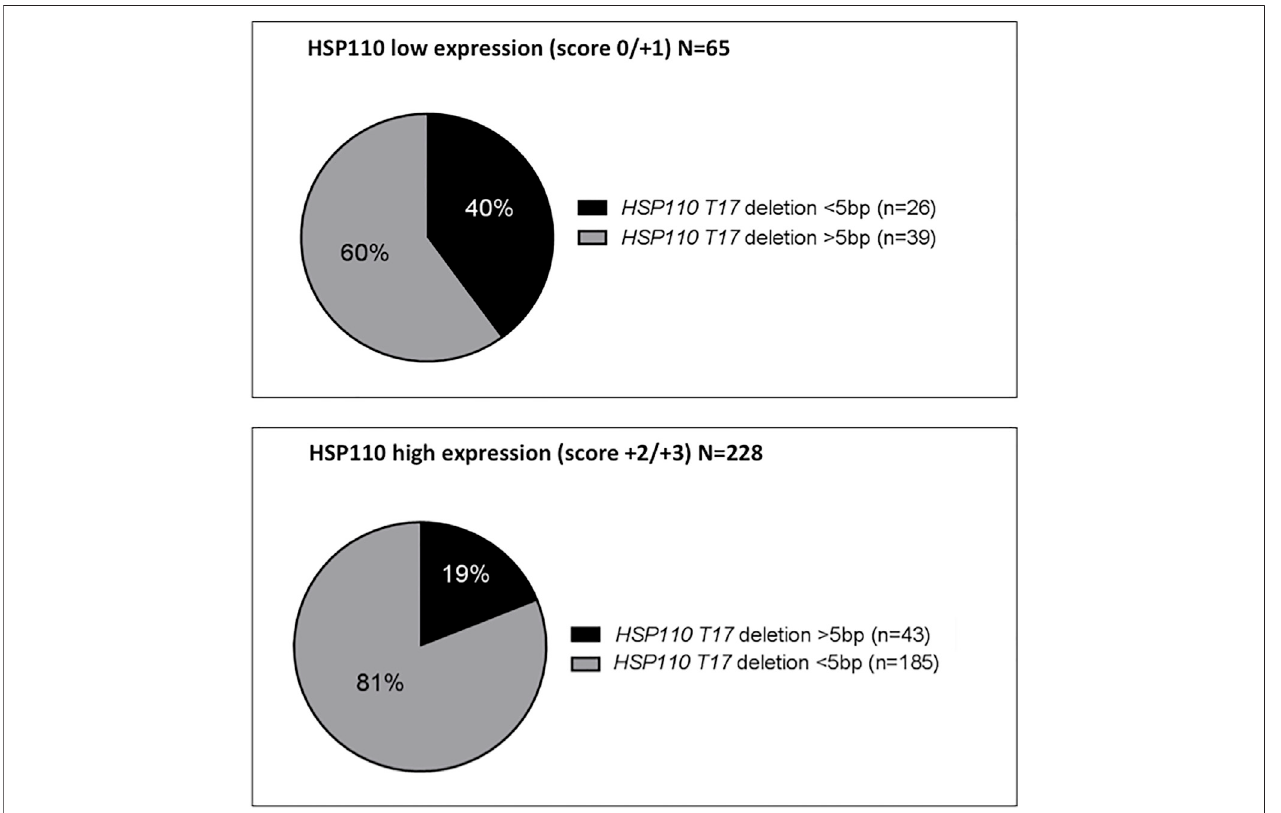
FIGURE 2 | Distribution of the size of HSP110 T 17 deletion according to HSP110